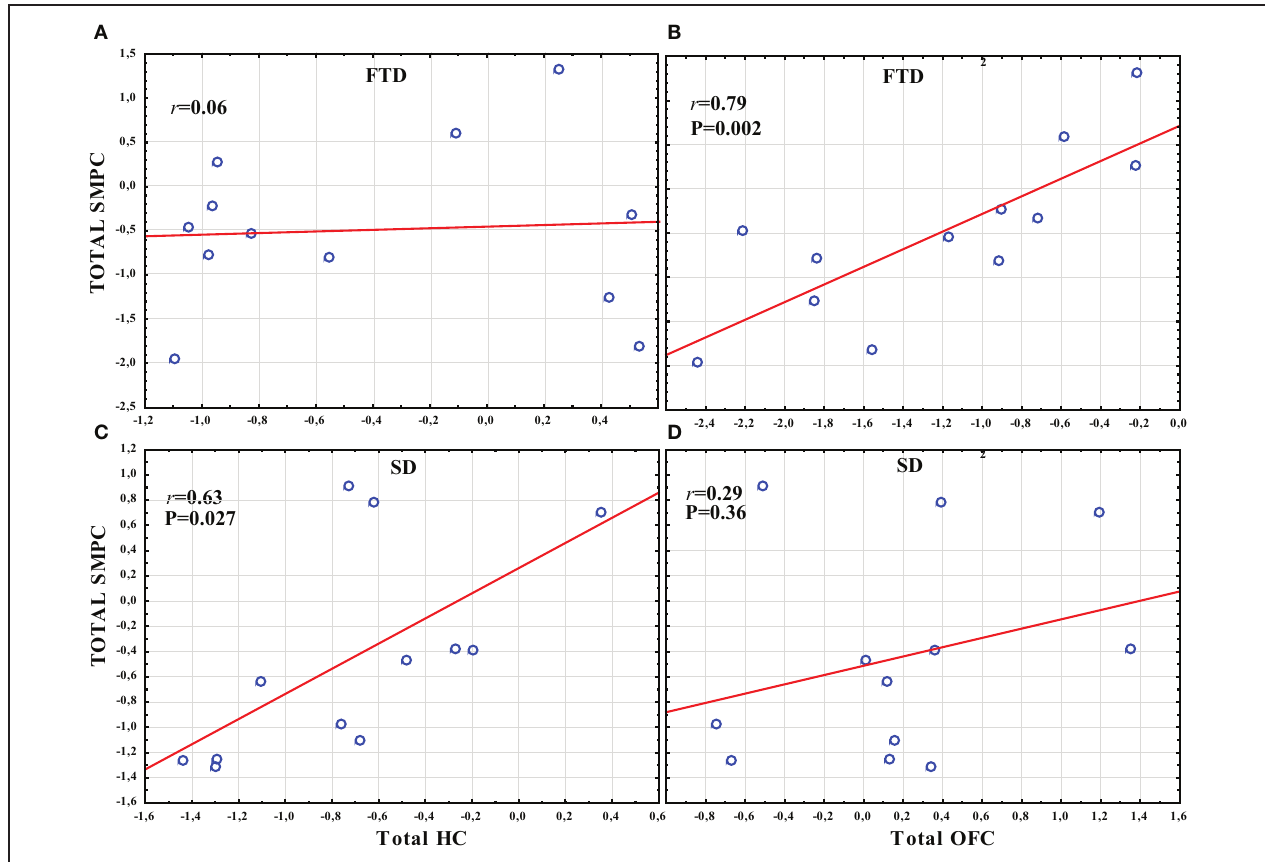
FIGURE 7 | The correlation between the total volume of SMPC, HC and OFC in SD and FTD. (A) The correlation between the total volume of SMPC and HC in FTD. (B) The correlation between total volume of SMPC and OFC in FTD. (C) The correlation between total volume SMPC and HC in SD. (D) The correlation between total volume of SMPC and OFC in